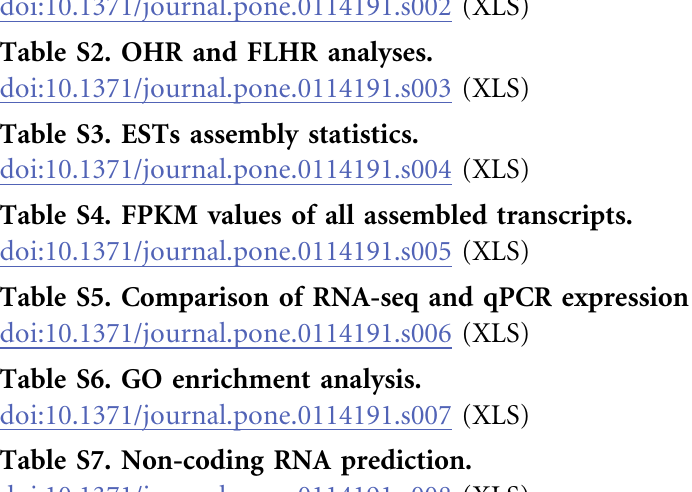
Table S1. Comparison with C. capitata full-length cDNAs. Table S2. OHR and FLHR analyses. Table S3. ESTs assembly statistics. Table S4. FPKM values of all assembled transcripts. Table S5. Comparison of RNA-seq and qPCR expression levels. Table S6. GO enrichment analysis. Table S7. Non-coding RNA prediction. Methods S1. List of software utilized for the four tested filtering conditions. Methods S2. List of primers utilized in this